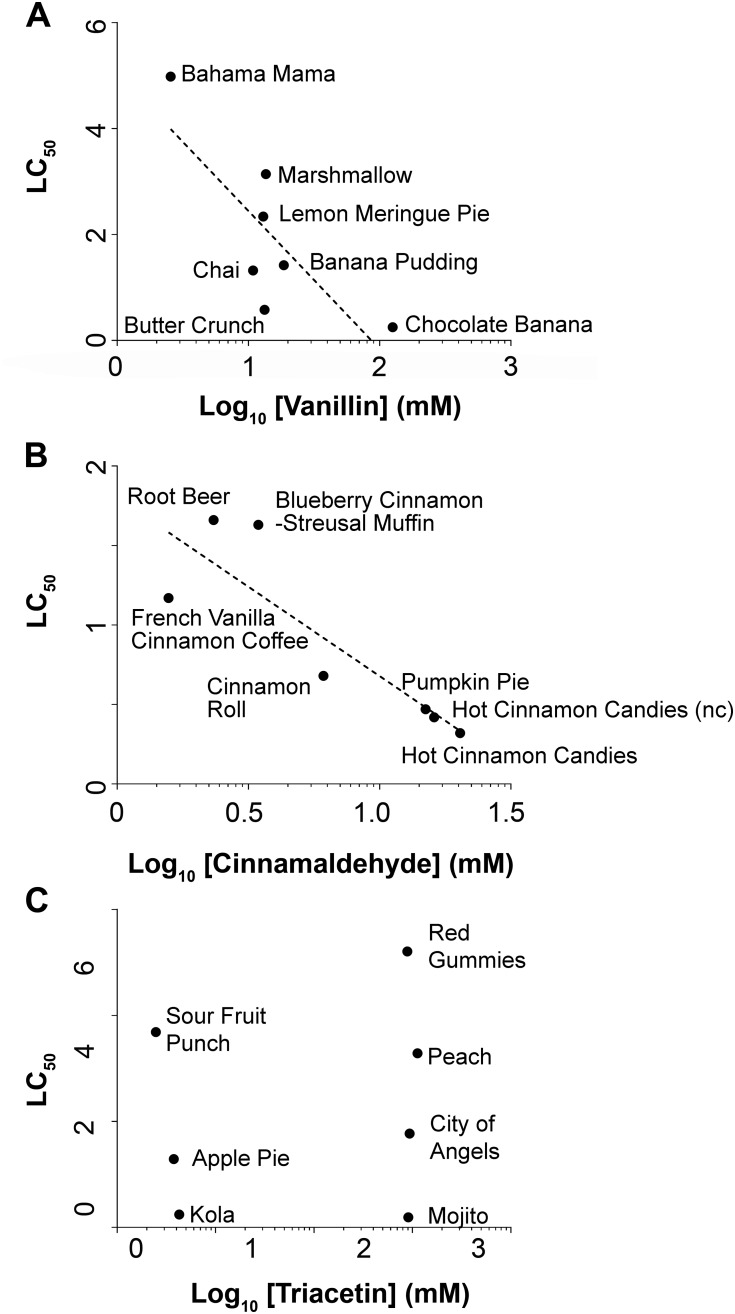
Vanillin and cinnamaldehyde concentrations correlate with toxicity in select e-liquids.(A) Graph showing toxicity (LC50) versus “vanillin” in select e-liquids. LC50 = −2.70 × log10(vanillin [M]) + 5.06; R2 = 0.62 (linear regression analysis). (B) Graph showing toxicity (LC50) versus “cinnamaldehyde” in select e-liquids. LC50 = −1.12 × log10(cinnamaldehyde[M]) + 1.08; R2 = 0.75 (linear regression analysis). (C) Graph showing toxicity (LC50) versus “triacetin” in select e-liquids. “N.B.” = no linear relationship was detected for triacetin. We used this chemical as an example of nontoxic control. Raw data are available in S7 Data. LC50, concentration at which a given agent is lethal to 50% of the cells; nc, no nicotine.